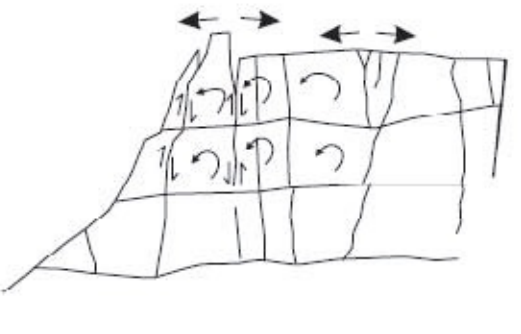
Figure 2: Toppling failure mechanism (after Hoek et al., 1977)